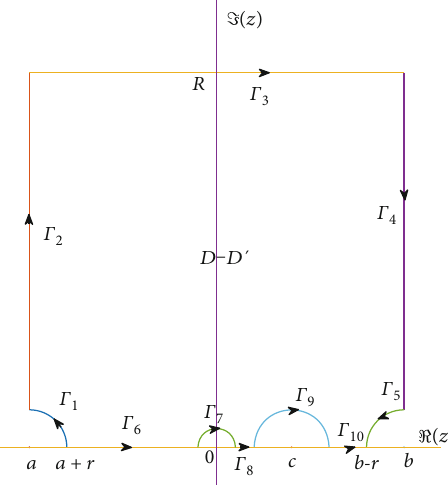
Figure 1: The integration